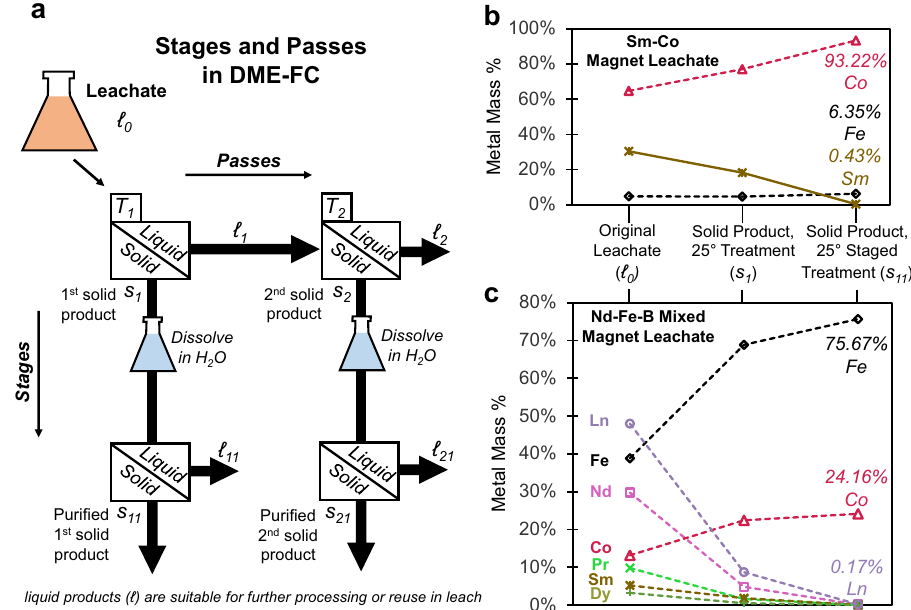
Fig. 4 Sequential treatments in stages and passes in DME-FC. a Scheme depicting stages and passes in DME-FC. DME-FC stages involve treatment of the initial leachate ( l 0 ), dissolution of the the solid product (e.g., s 1 ) in water, followed by treatment of the resulting solution to yield a higher-purity solid (e.g., s 11 ). DME-FC passes are successive treatments of the liquid stream to recover chemically distinct solid products (s 1 , s 2 ) from the same aqueous solution. Temperature control can enhance separations in passes (e.g., initial solid fraction s 1 recovered at temperature T 1 , followed by treatment at a different temperature (T 2 ) to recover a separate solid fraction (s 2 )), and can also be used to enhance puri fi cation via DME-FC stages. As the chemical character of the solution remains unchanged, albeit with reduced salt concentration, liquid products are suitable for further hydrometallurgical processes upstream or downstream of the separation. ICP-OES metal compositions depicting the puri fi cation from original solution ( l 0 ), fi rst solid product (s 1 ), and solid product produced through staging (s ) with treatments at 25 °C for b Sm-Co magnet leachate and c Nd-Fe-B mixed magnet leachate. Sum of the 11 lanthanide elements (Nd, Pr, Sm, and Dy) is given as Ln. Separation factors for both b and c are listed in Table 2. Source data are provided as a Source Data fi